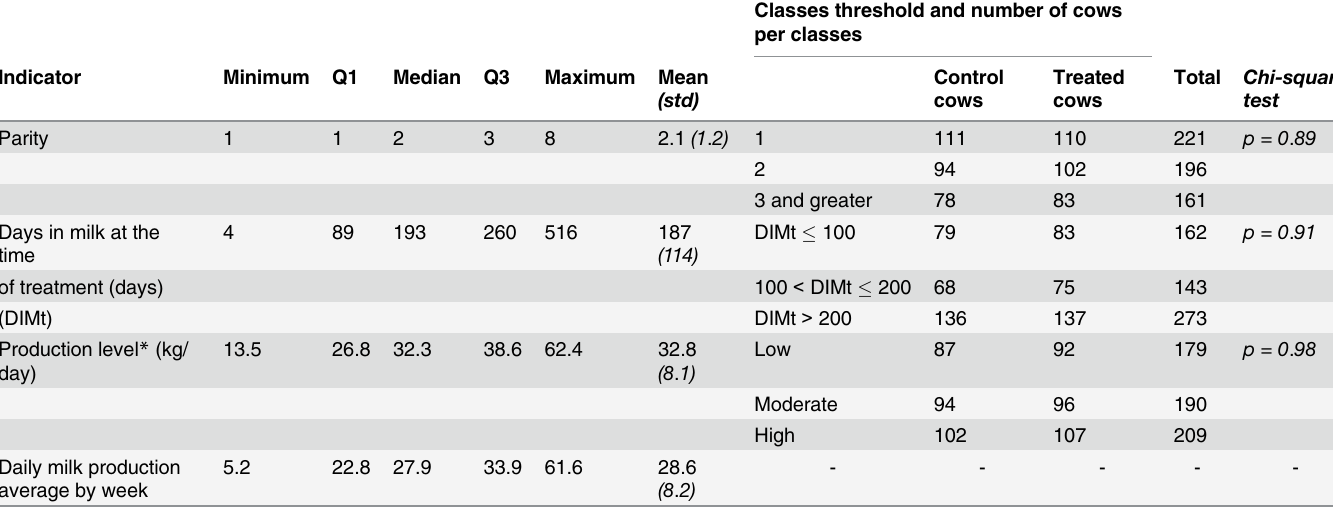
Table 2. Description of the dataset (578 cows in 13 herds, 295 treated cows, 283 control cows): distribution and classification of individual produc- tion-based indicators characterizing cows, number of treated cows and control cows per classes for each categorized indicator, and distribution of the daily milk production average by